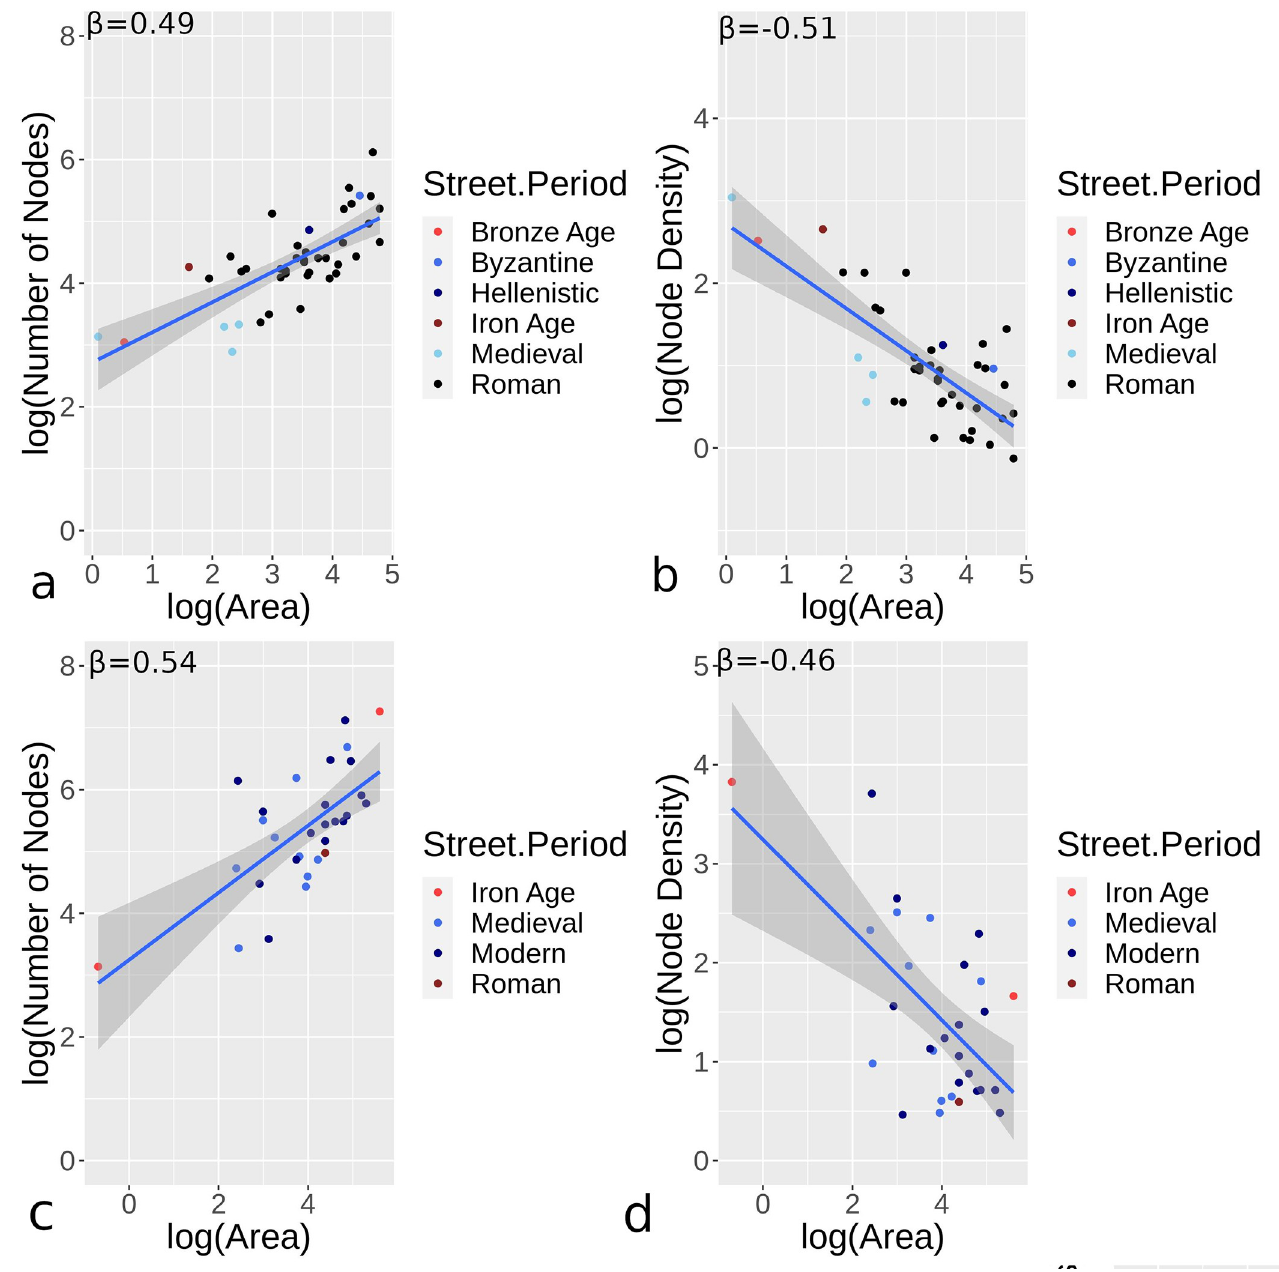
Fig 6. Orthogonal (a-b) and hybrid/organic (c-d) urban sites studied with the number of nodes (a,c) and density (number of nodes/ha; b,d) compared to area. North Africa are collected, where results demonstrate comparable scaling values for the varied periods and regions. As a wider contribution, this work presents the street centrality tool as an open contribution along with street data and centrality outputs presented. Structurally, some centrality distribution measures show some similarity between orthogonal and hybrid/organic urban sites, but there are evident differences between orthogonal and hybrid/organic sites. All distributions showed significant differences when statistically compared. OOrthogonal sites